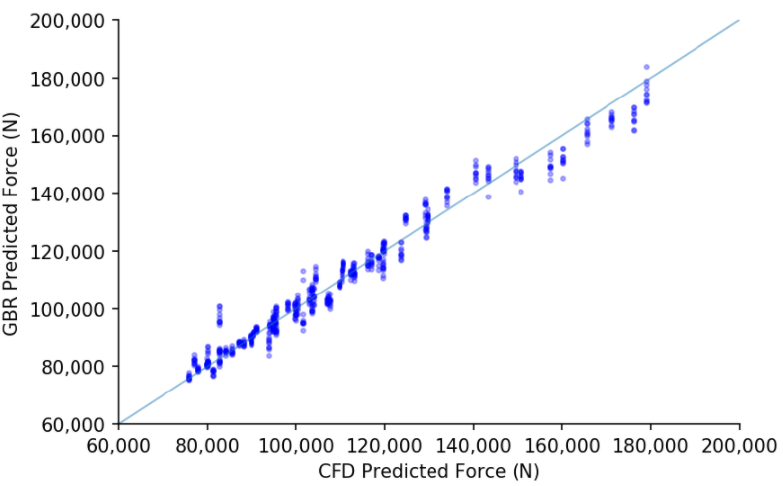
Figure 16. Force prediction for CFD vs. GBR for 8° .